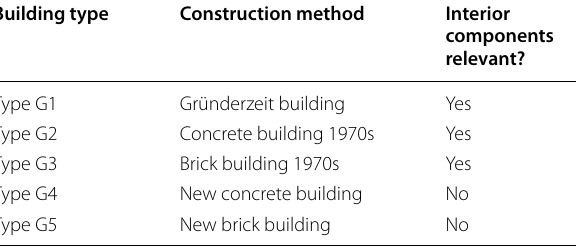
Table 5 Relevance of the interior components with regard to heat storage according to the results of the one-dimensional model